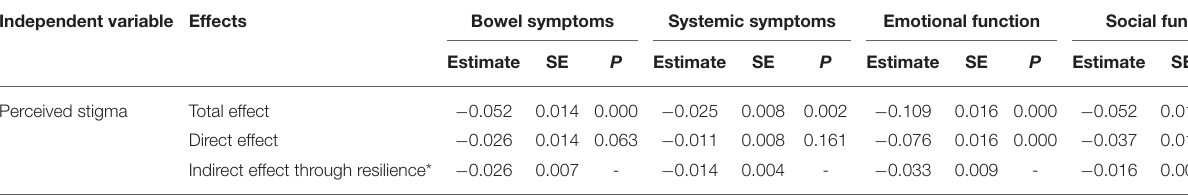
TABLE 4 | Direct and indirect (mediation) effects of perceived stigma on quality of life ( N = 311). Independent variable Effects